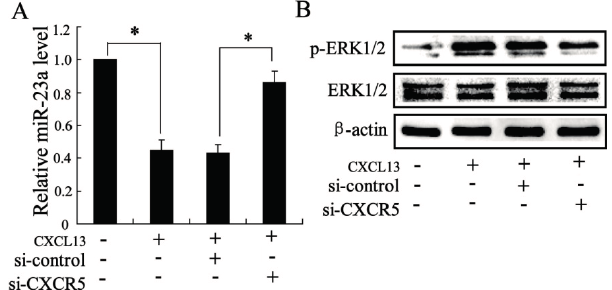
Figure 4. The effects of CXCL13 on miR-23a and MAPK molecules expression in vitro . ( A ) The miR-23a expression; ( B ) The protein expression of ERK1/2. Data were shown as mean ± SD; t -test of independent sample was used to analyze the difference between two groups; * considered as significant